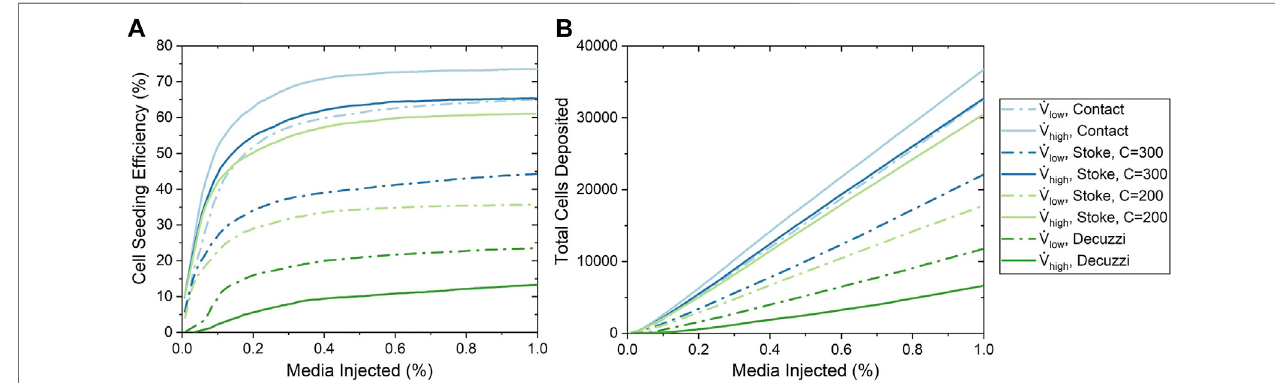
FIGURE 7| Cell seeding ef fi ciency and the total number ofcells deposited asa function ofthe percentage of media injected for various cell seeding algorithms. (A) Cell seeding ef fi ciency. (B) Total number of cells deposited.